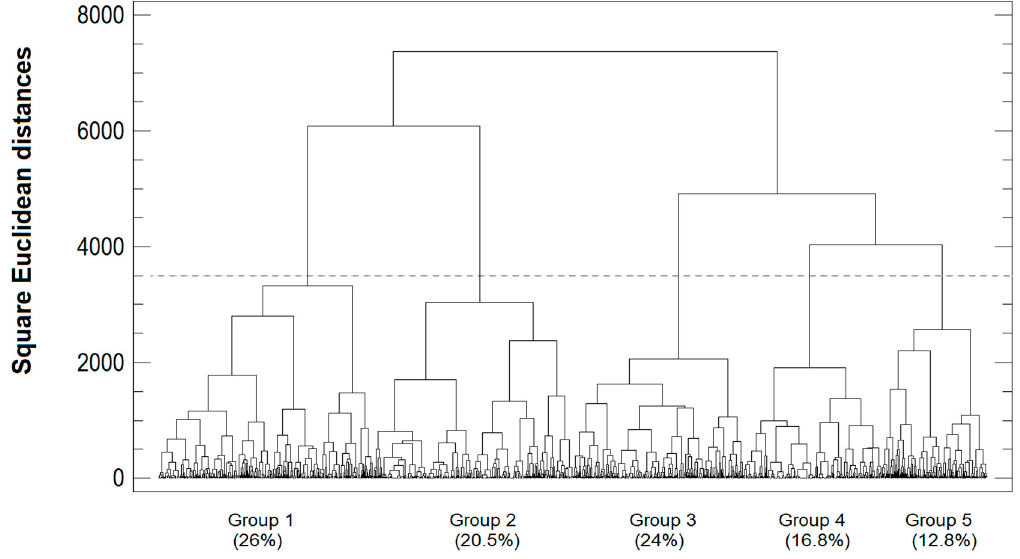
Figure 1. Dendrogram classification of dual-purpose farms in Mexico (farms, %).